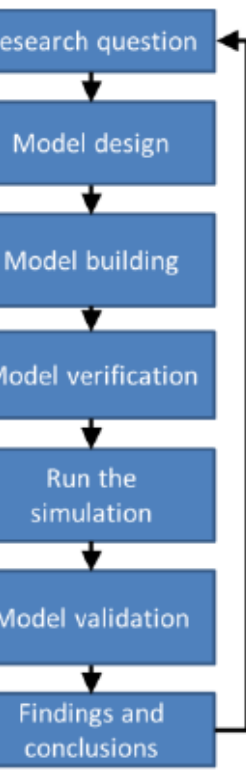
Fig. 1. Simulation